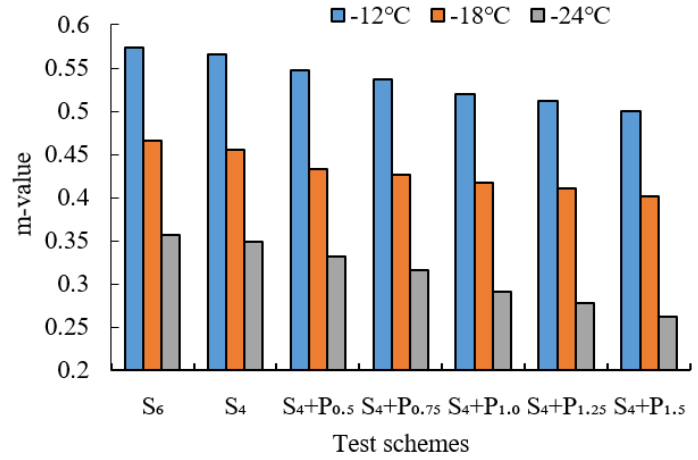
Figure 10. m-value of PPA – SBS and DH – 70# asphalt.